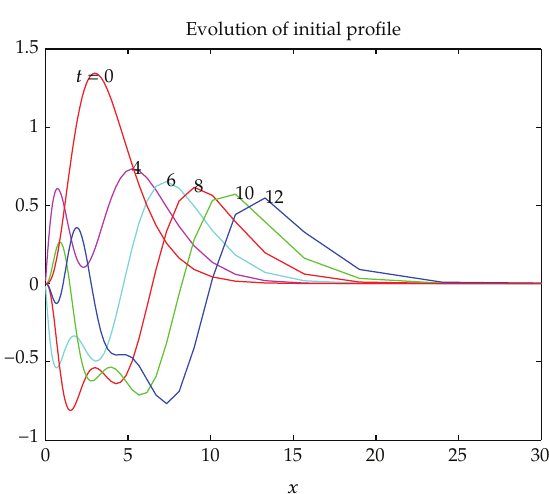
Figure 11: Example 5.2: by quasi-uniform